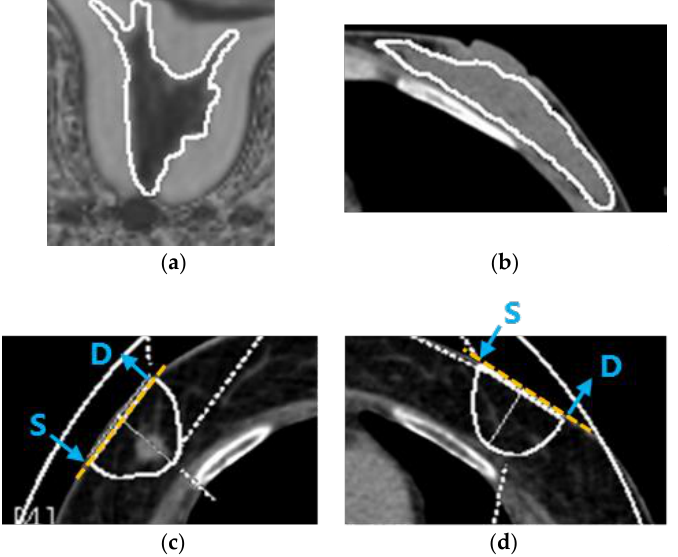
Figure 1. ROIs on MRI and DECT. ( a ) ROI on an MRI image of fibroglandular tissue in a normal breast in the first part of the study. ( b ) ROI on a DECT image of fibroglandular tissue in a normal breast in the first part of the study. ( c ) ROI on a DECT image of breast cancer in the second part of the study. ( d ) ROI on a DECT image in a symmetrical area of the contralateral breast in the second part of the study. Yellow dashed lines show the measurement axes for TD-DOS. Blue arrows indicate the position of the source (S) and detector (D) fiber bundles.